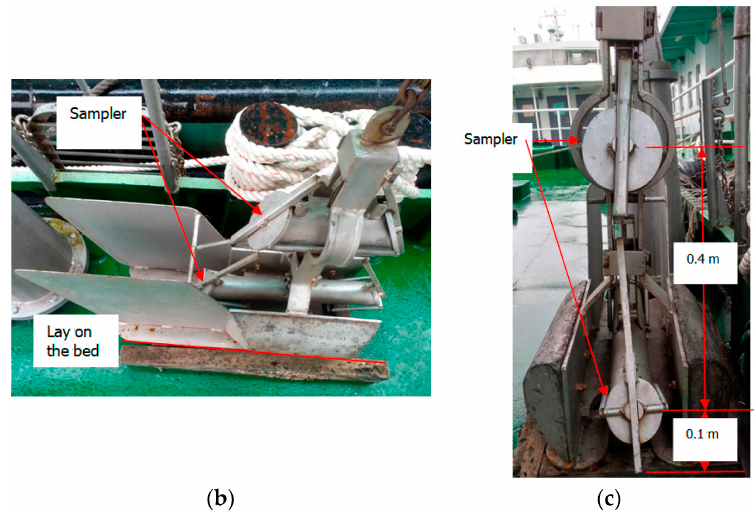
Figure 2. Samplers for suspended sediment in the field survey; ( a ) is the sampler with fish lead, and ( b , c ) are the samplers for sampling suspended sediment at the two near-bed points (different camera